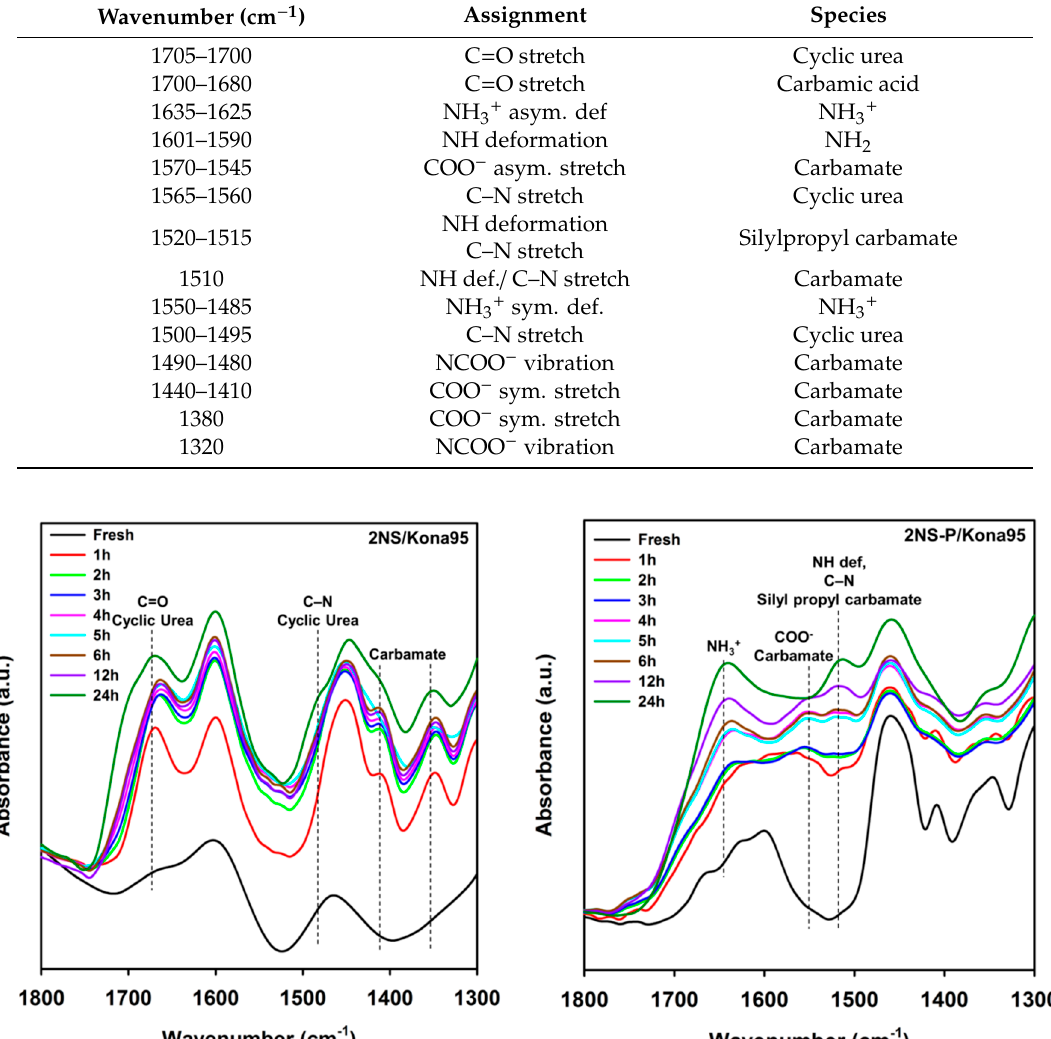
Table 3. IR peak assignments for the species formed from the reaction between CO 2 and amine.